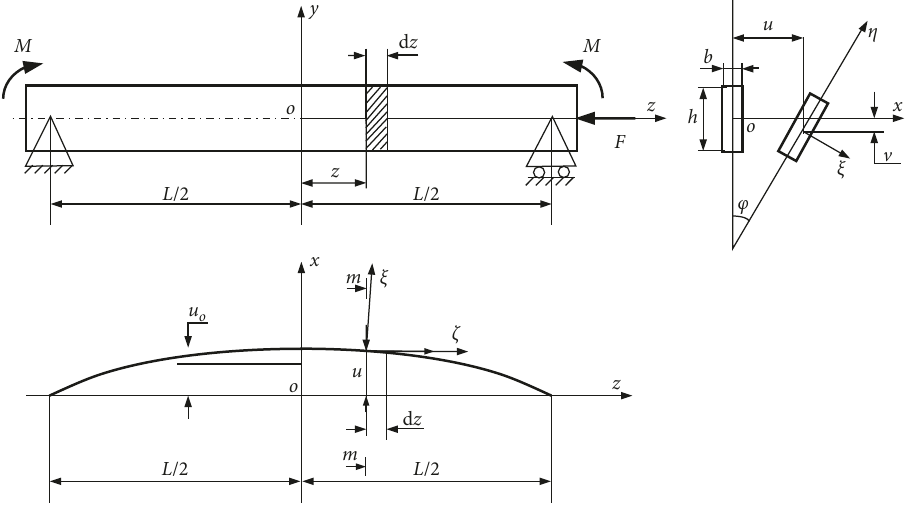
Figure 1: Thin-walled beam model.